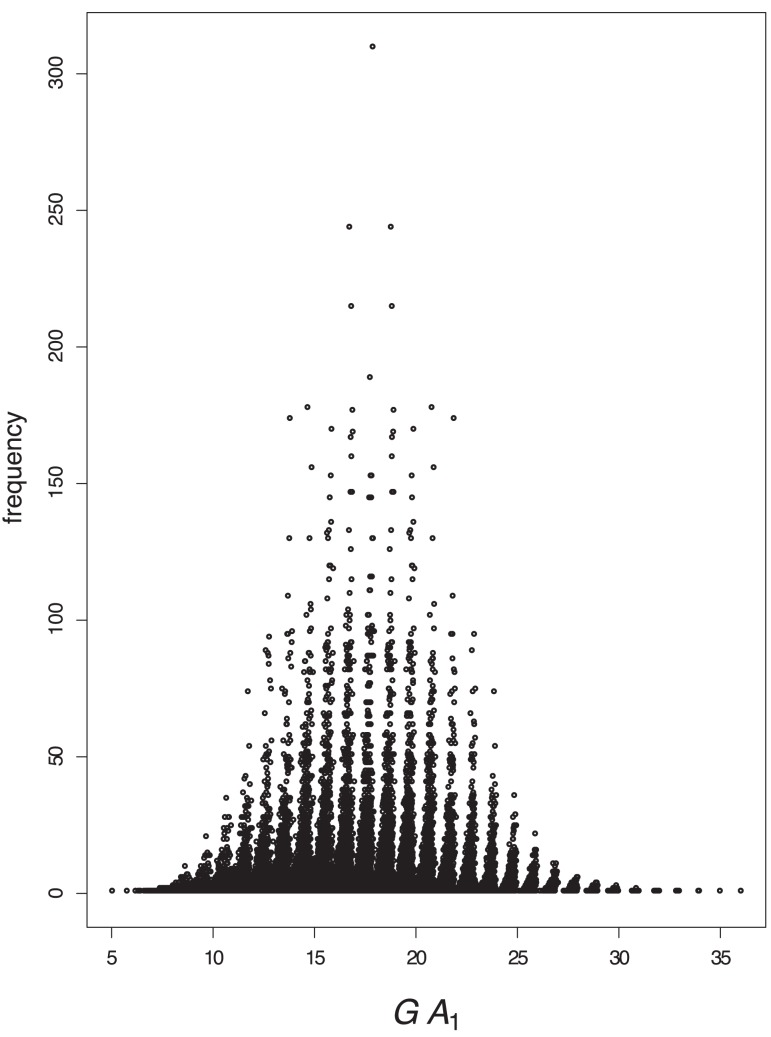
Value distribution for GA1.